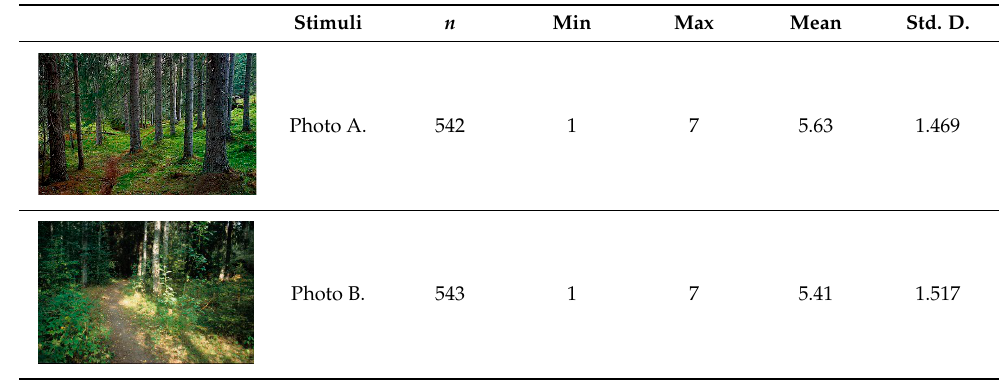
Table A1. Mean score, standard deviation (S.D.) and number of respondents who provided preference scores for 15 images and 25 verbal preconceptions of recreational infrastructure and use of this infrastructure in boreal forest setting.